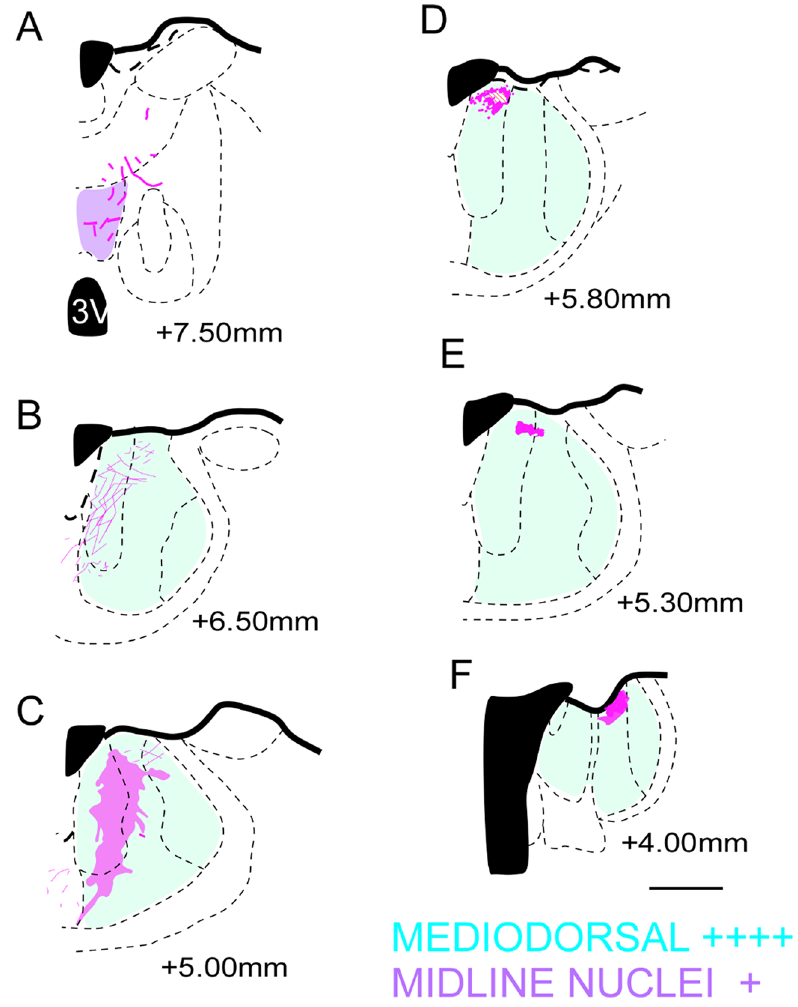
Figure 7. Location of the fibers from the A25 (in purple) in the diencephalic complex. ( A – C ) case 3; ( D – F ) case 4; The shaded area corresponds to the plexuses: high density of fibers. + : Isolated axons; + + : Low presence of fibers; + + + : moderate presence of fibers; + + + + : high presence of fibers; Scale bar: 1000 µm. The figure was drawn in Canvas software version